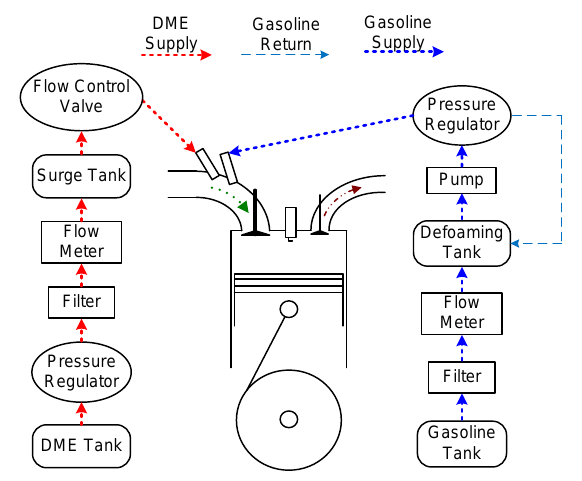
Figure 3. Experimental setup for the fuel supply system.